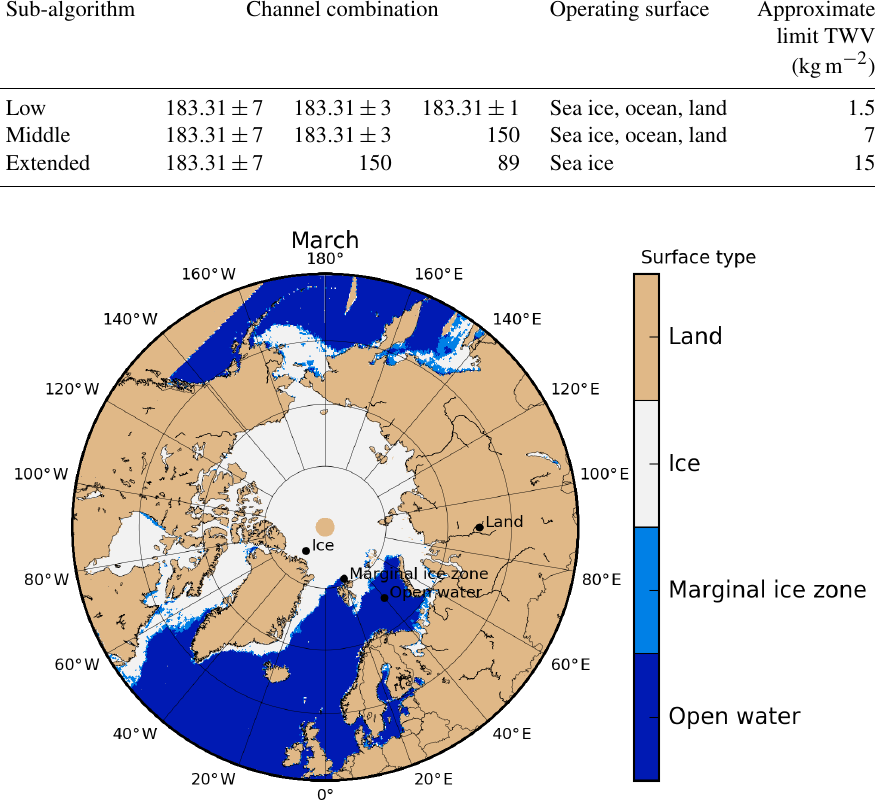
Figure 2. Locations of the points chosen for the surface characterization study for TWV are shown in black. As background, the surface classification used in the TWV algorithm, obtained from ASI algorithm ice concentration (Spreen et al., 2008) for a typical day in March (6 March 2008) is